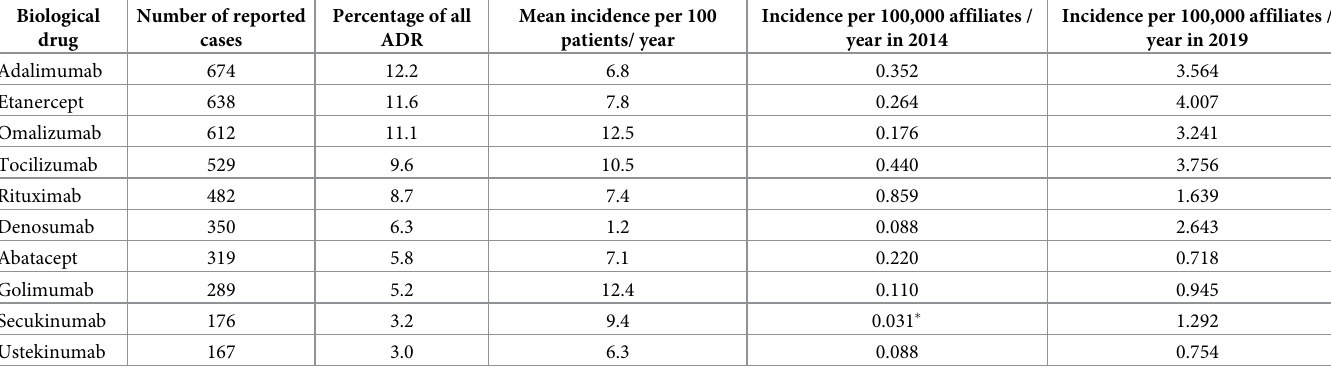
Table 4. Top 10 biological agents with the highest number of reports and their incidences in Colombia from